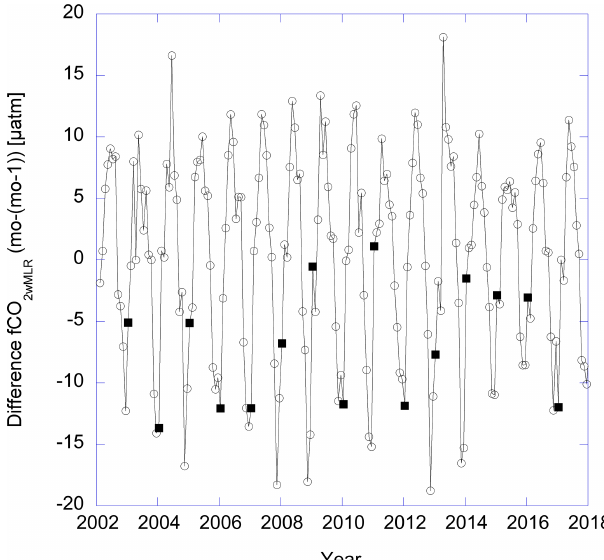
Figure 3. The difference between f CO 2wMLR for subsequent months plotted versus time. The solid squares are the differences between December and January where different MLRs are used.